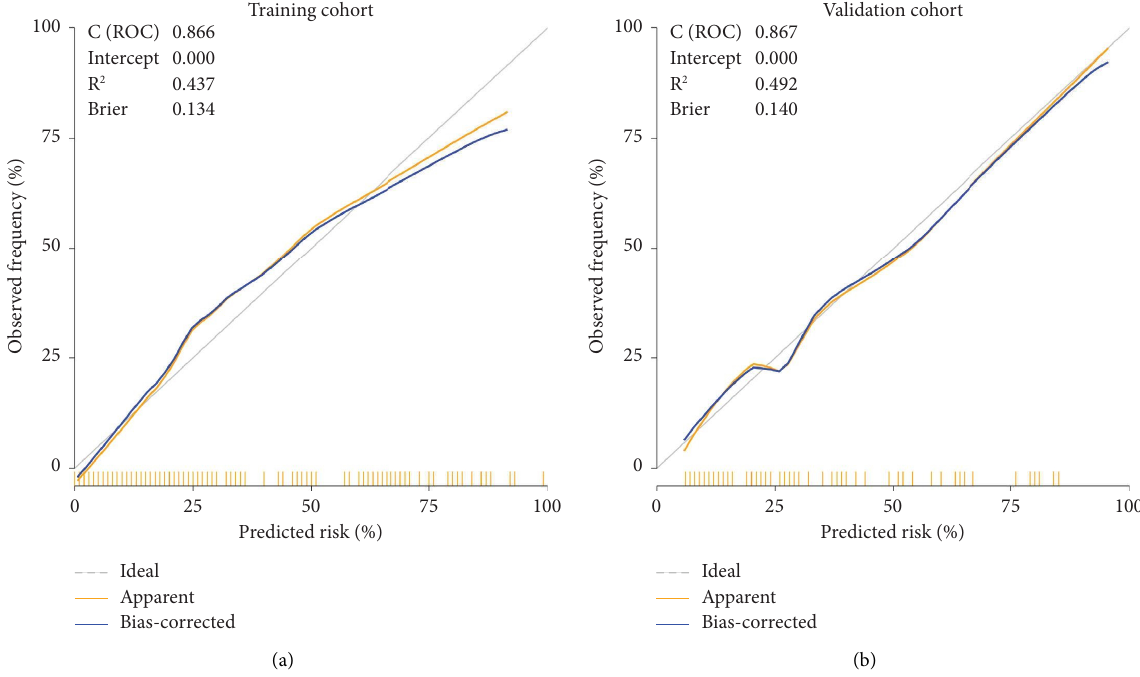
Figure 3: Validity of the predictive performance of the nomogram in estimating the risk of SH presence in the training cohort ( n � 208) and in the validation cohort ( n �